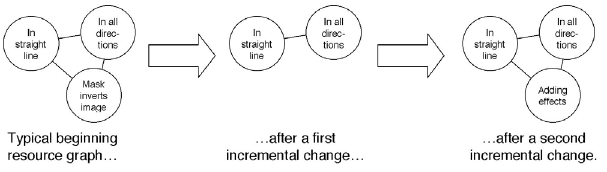
FIG. 5. Incremental change in studying light and shadow. Two incremental changes occur, both deletion and addition.